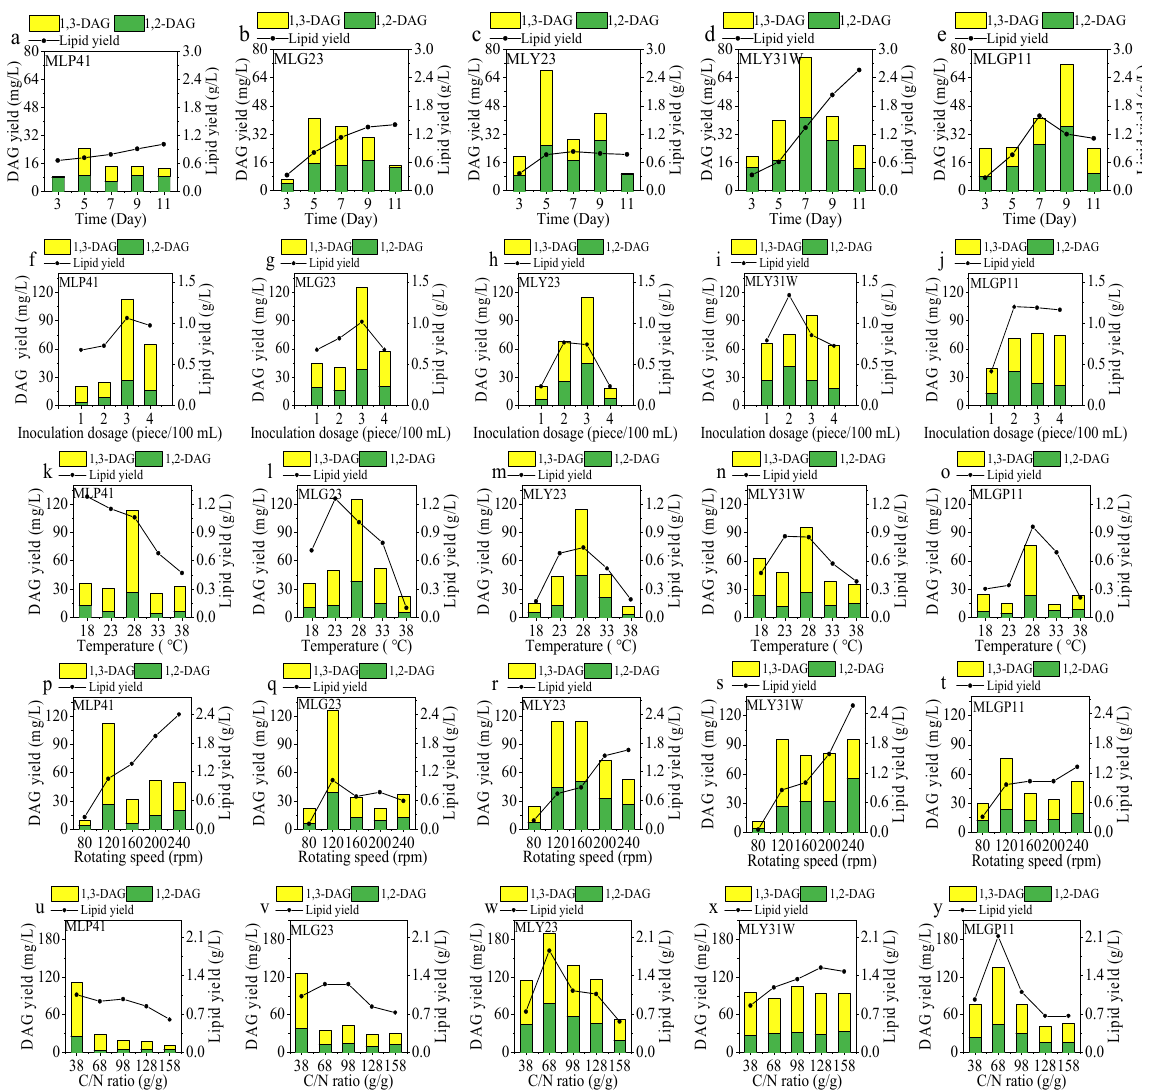
Figure 4. Effect of fermentation conditions on the yields of lipids and DAG from the five fungi coded as MLP41, MLG23, MLY23, MLY31W, and MLGP11: ( a – e ) fermentation time, ( f – j ) inoculation